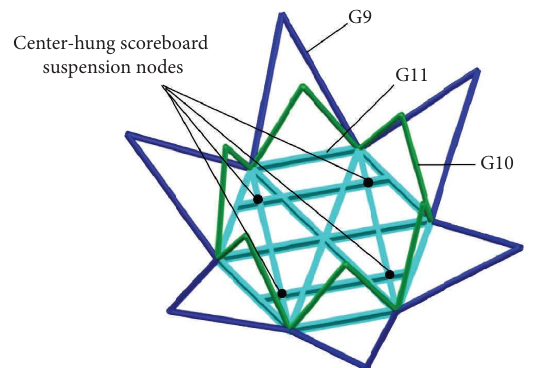
Figure 3: Te support platform for the CHS.